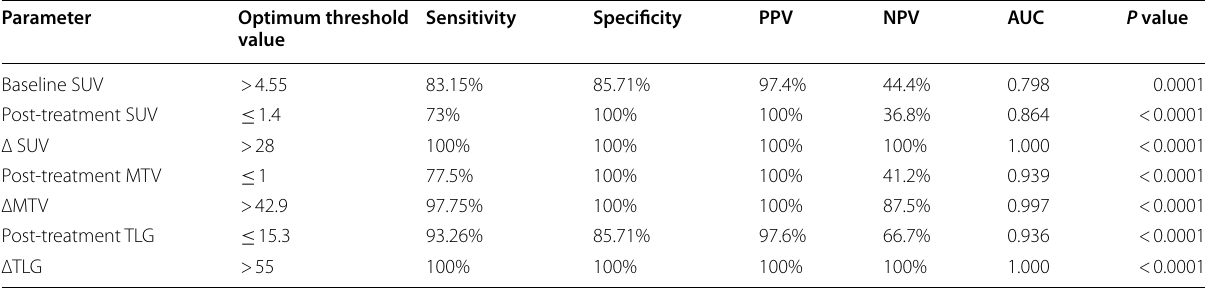
Table 1 The sensitivities, specificities, PPV, NPV, accuracies, AUC, and P values of the optimum threshold values of the quantitative PET/CT parameters for differentiation of responsive from the non-responsive group Parameter